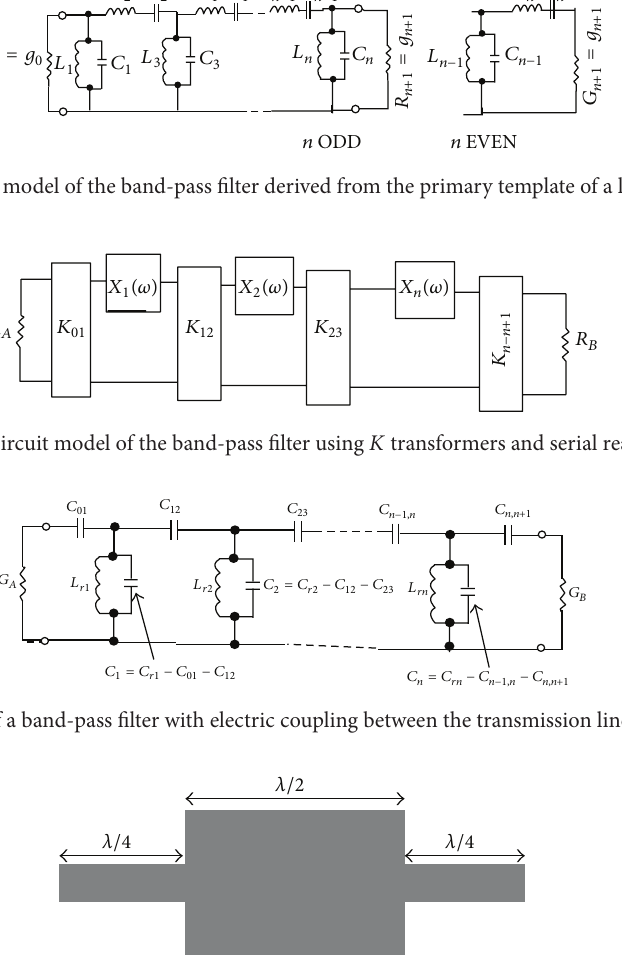
Figure 5: The structure of a